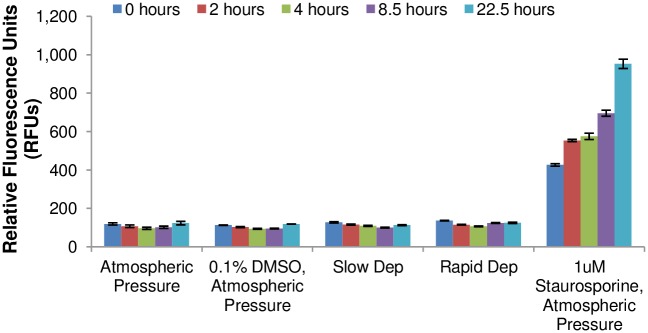
Level of BAEC death following pressurization as indicated by CellTox.Cell viability was monitored over the course of 24 hrs for an ambient atmospheric pressure negative control, a vehicle negative control (0.1% DMSO), two experimental groups that received a 100 mm Hg hydrostatic pressure treatment for 3 hrs and were then either slowly or rapidly depressurized, and finally a staurosporine treated (1μM for 24 hrs before measurements) positive control. Cell viability was monitored by measuring fluorescence on a plate reader (RFU = relative fluorescence units). Error bars represent SE. Data is the mean of three to five replicates per experimental group.